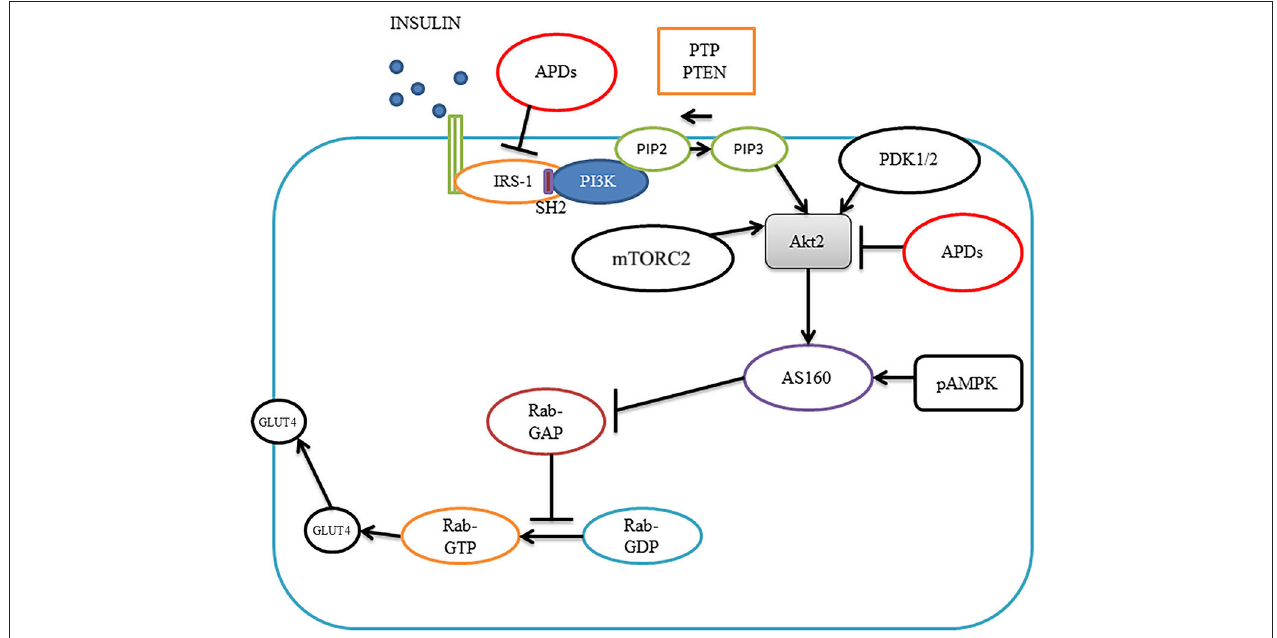
FIGURE 1 | Insulin signaling pathways and antipsychotic effects . Insulin binds to insulin receptors to activate IRS1, leading to activation of PI3K, which converts PIP2 into PIP3, PIP3 brings Akt2 on to the membrane where PDK1/2 and mTORC2 phosphorylate Akt2. Akt2 activates AS160, which blocks Rab-GAP, leading to increased Rab-GTP, causing translocation of GLUT4 to the membrane for glucose transportation. Antipsychotics can diminish insulin-induced IRS-1 phosphorylation and inhibit Akt activity causing insulin resistance. Akt2, protein kinase 2; pAMPK, phosphor-AMP-activated protein kinase; APDs, antipsychotic drugs; GLUT4; glucose transporter type 4; IRS1, insulin receptor substrate 1; PI3K, phosphoinositide 3-kinase; PIP2, phosphatidylinositol (3,4)-bisphosphate; PIP3, phosphatidylinositol (3,4,5)-trisphosphate; PDK1/2, phosphoinositide-dependent kinase-1; mTORC2 mammalian target of rapamycin complex 2 and SH2, Src homology